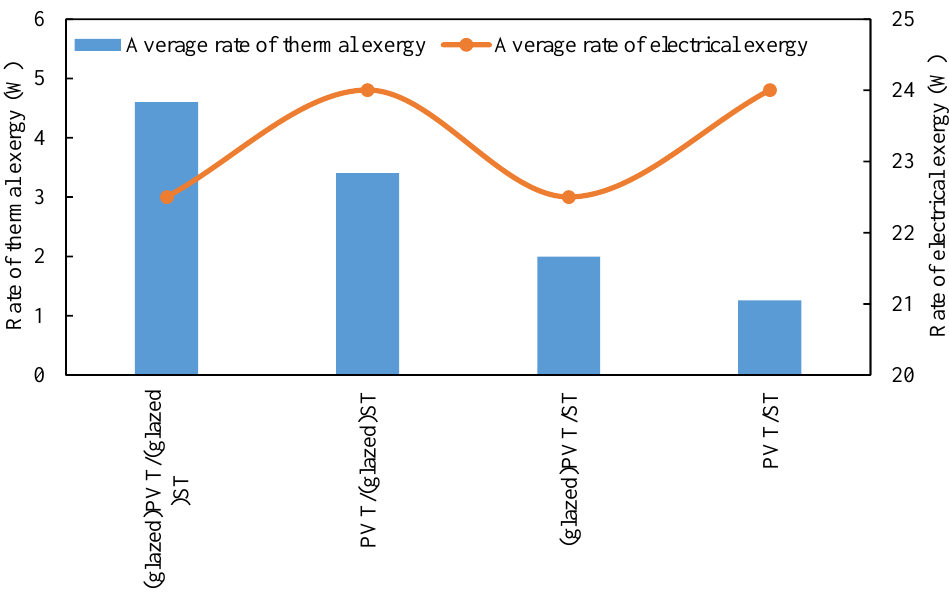
Fig. 13 Average rate of thermal and electrical exergy for different PVT/ST with and without glass cover on various parts at the mass flow rate of 50 kg/h during a day in